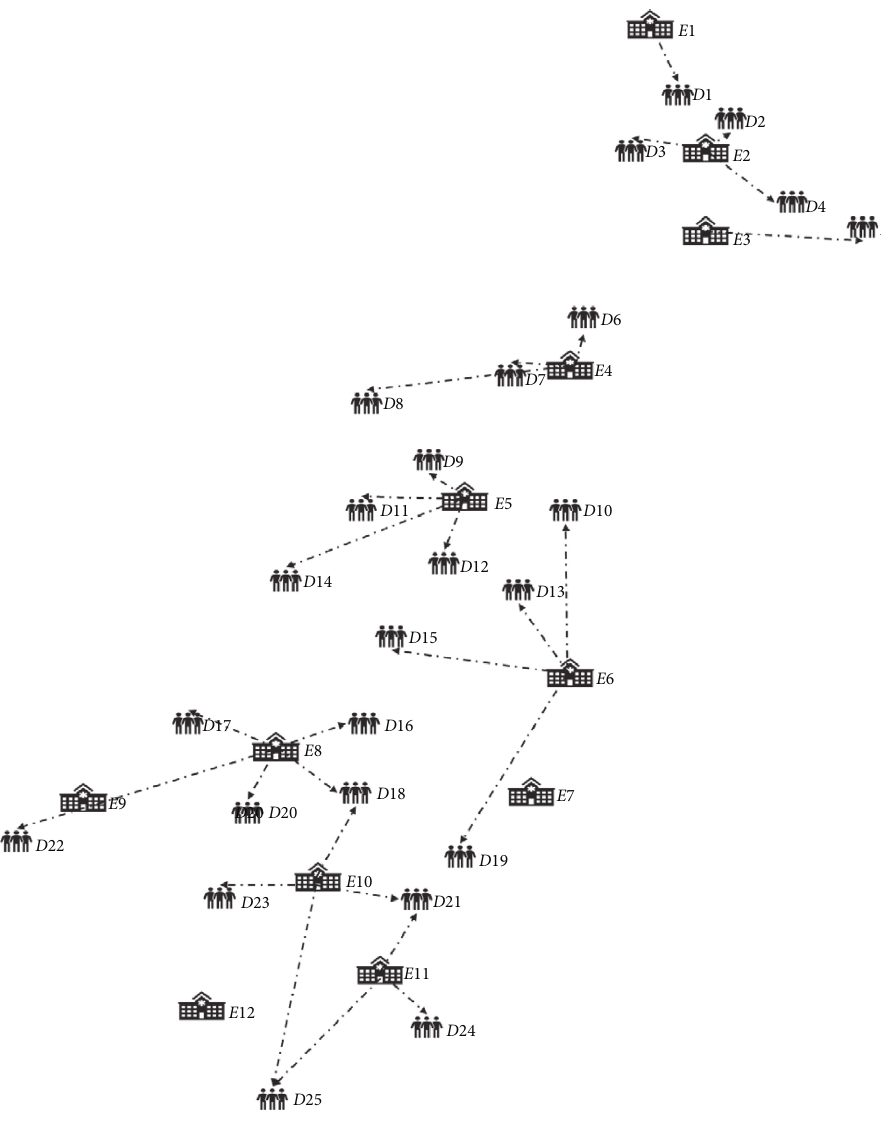
Figure 8: MIRP-ellipsoid